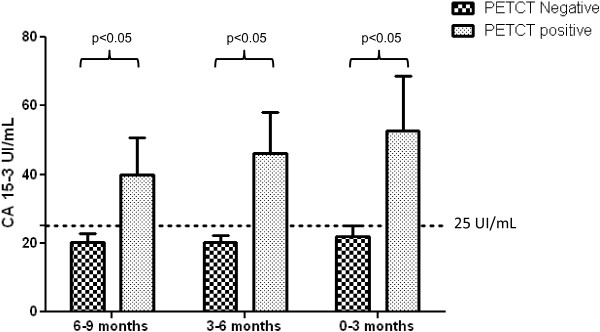
Correlation between the trend in serial CA15-3 measurements and PETCT findings. The bar plot shows the mean CA15-3 serum levels at 0–3, 3–6, and 6–9 months prior to PETCT. Dotted line indicates CA15-3 cut-off (25 UI/mL). The P-value was determined with an unpaired t-test.